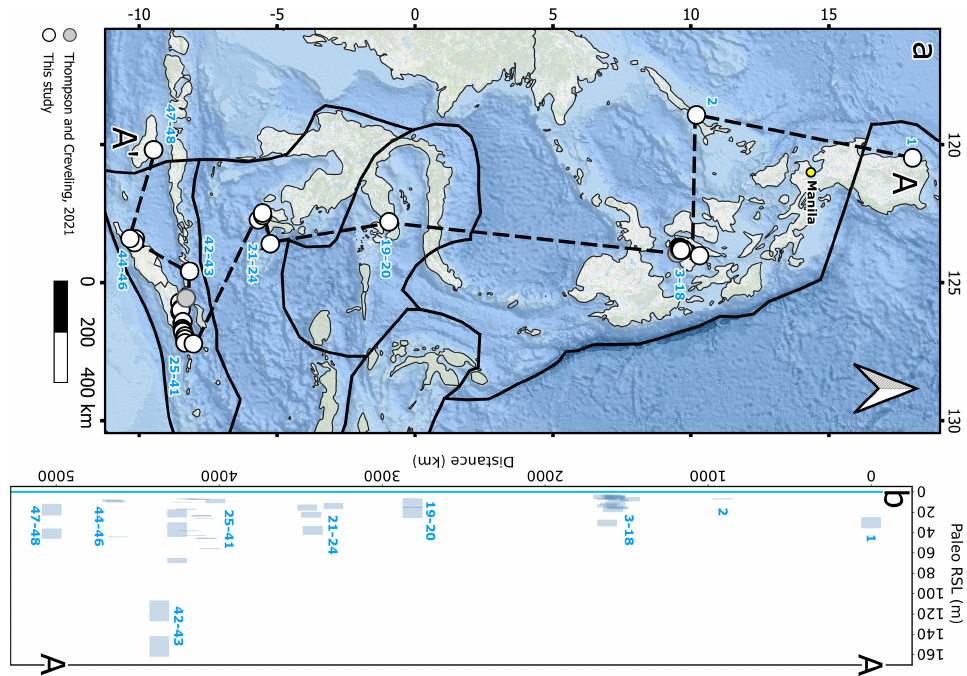
Figure 3. MIS 5 RSL index points described in this study, plotted on a north-to-south transect (A-A’). (a) Map of sites, including those reviewed by Thompson and Creveling, 2021. Solid black lines indicate tectonic plate boundaries. (b) Paleo-RSL versus distance along the A-A’ transect shown in (a) . Note that this plot contains MIS 5a, 5c, and 5e data points. 1: Currimao Late Pleistocene terrace (MIS 5e)